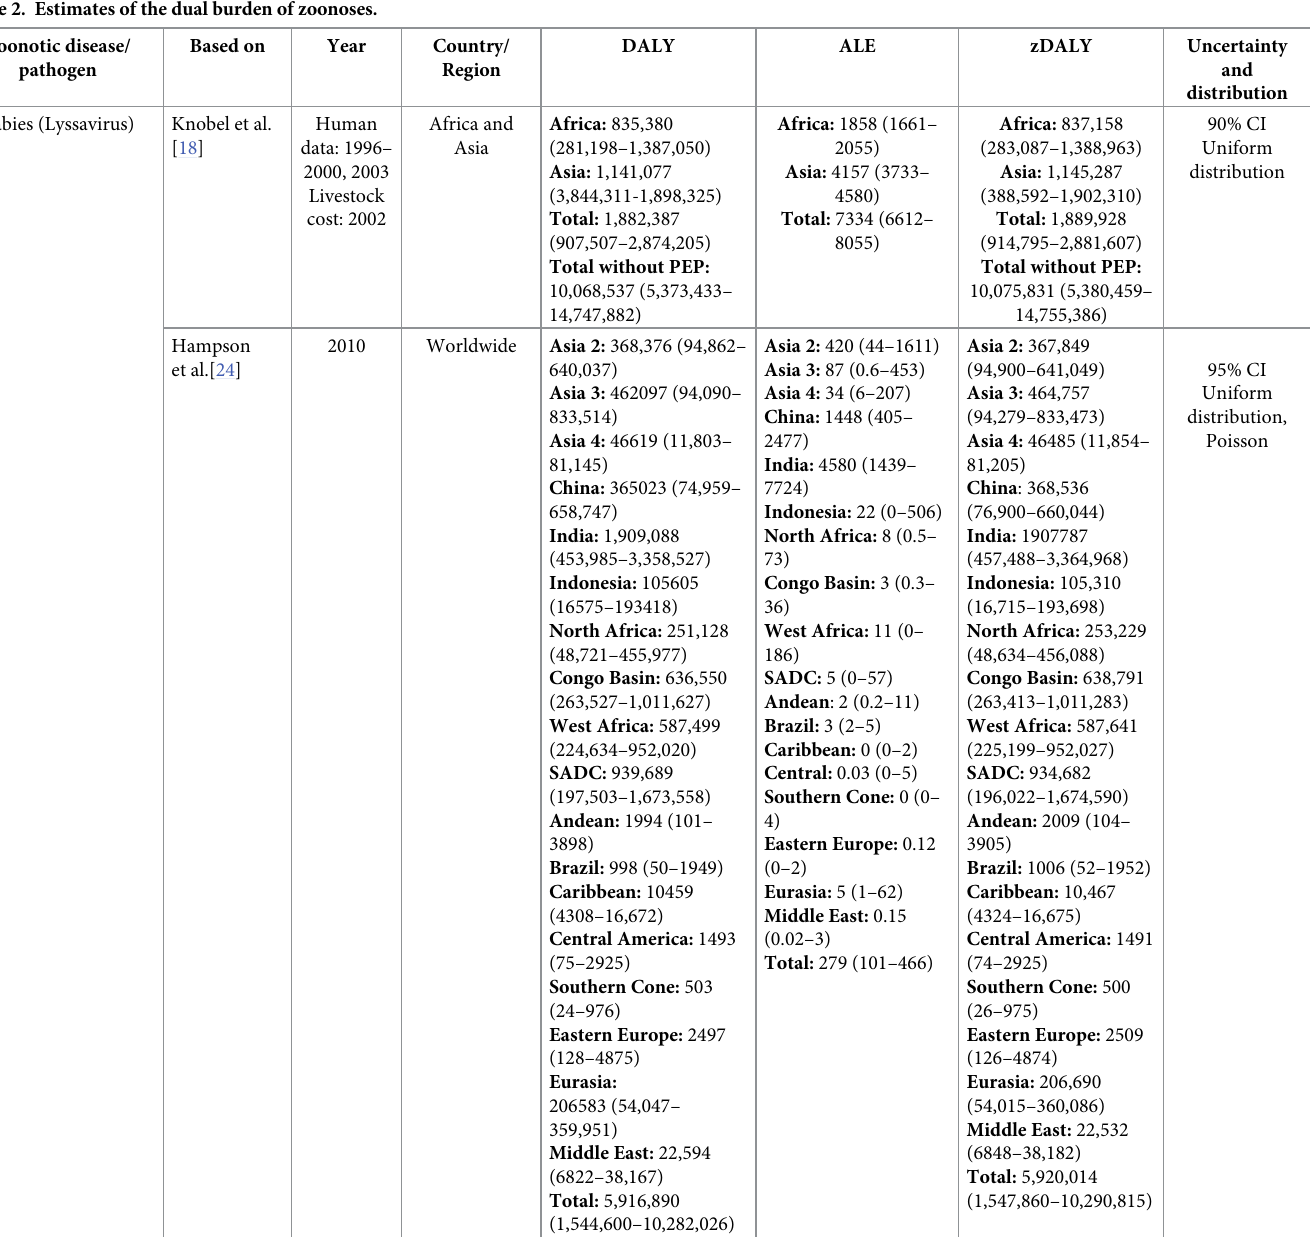
Table 2. Estimates of the dual burden of